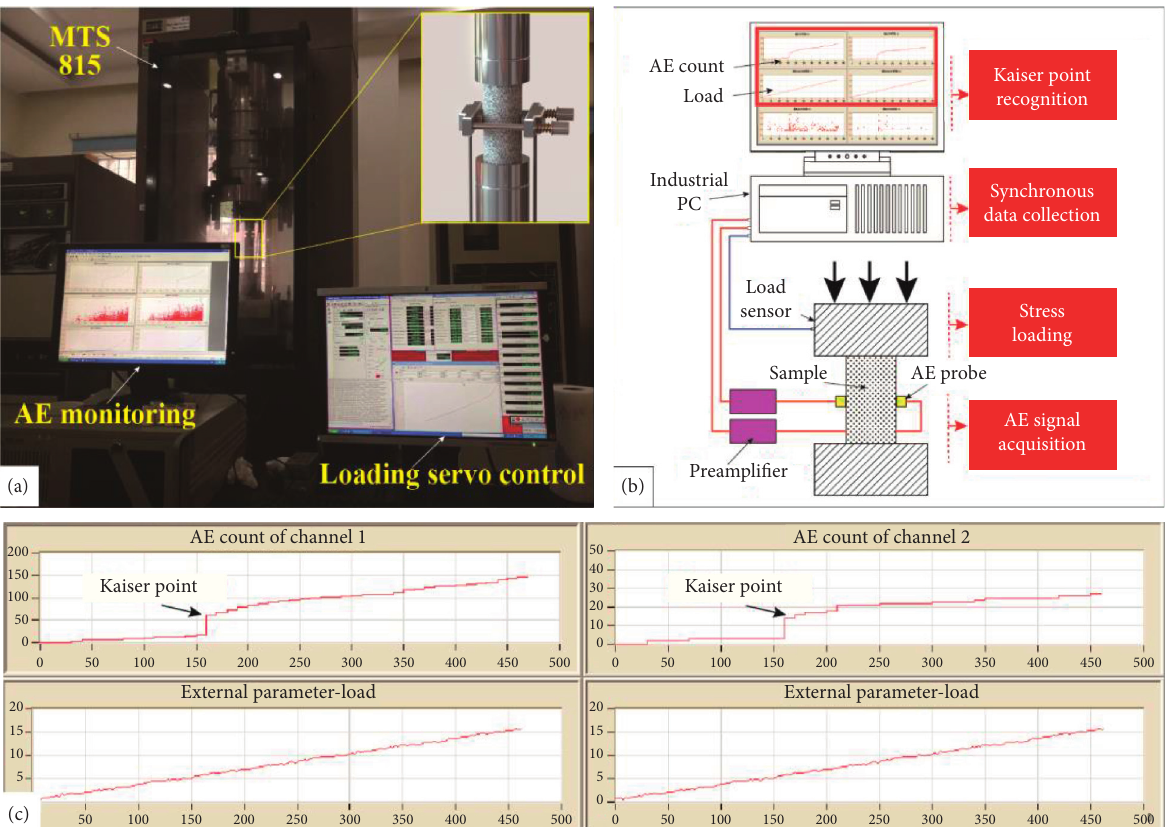
Figure 5: Test equipment. (a) MTS 815 material testing machine, (b) AE test schematic, and (c) identification of Kaiser